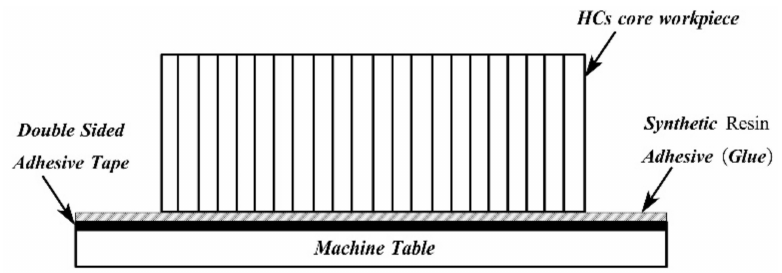
Figure 6. Schematic of workpiece clamping